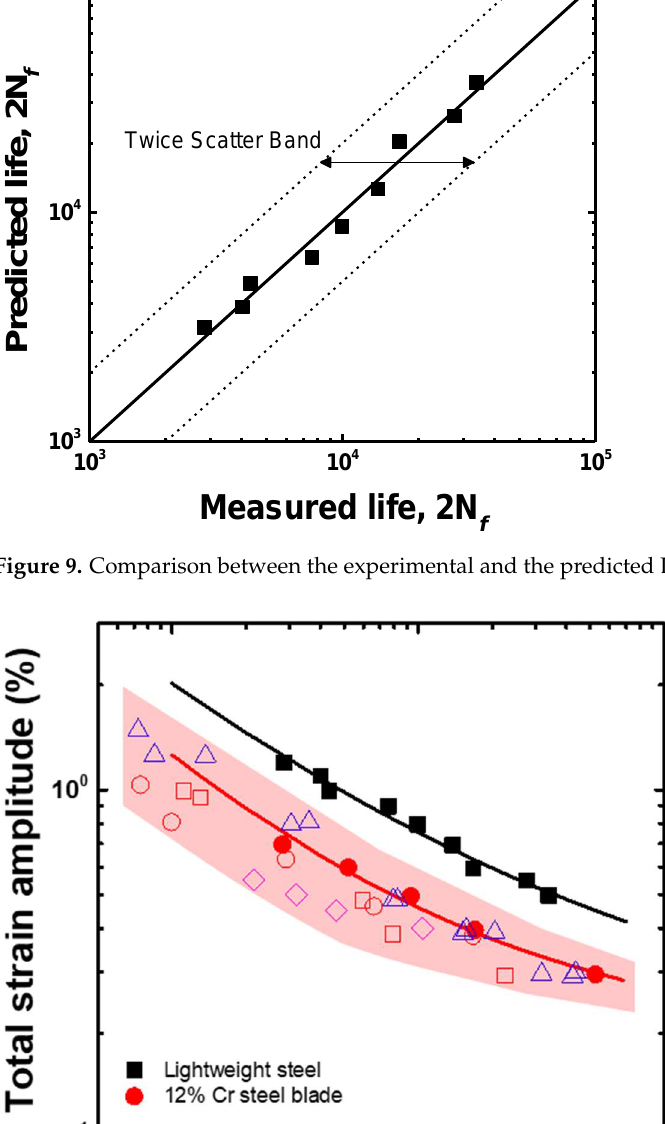
Figure 8. LCF life curve as a function of the number of the reversals to failure.